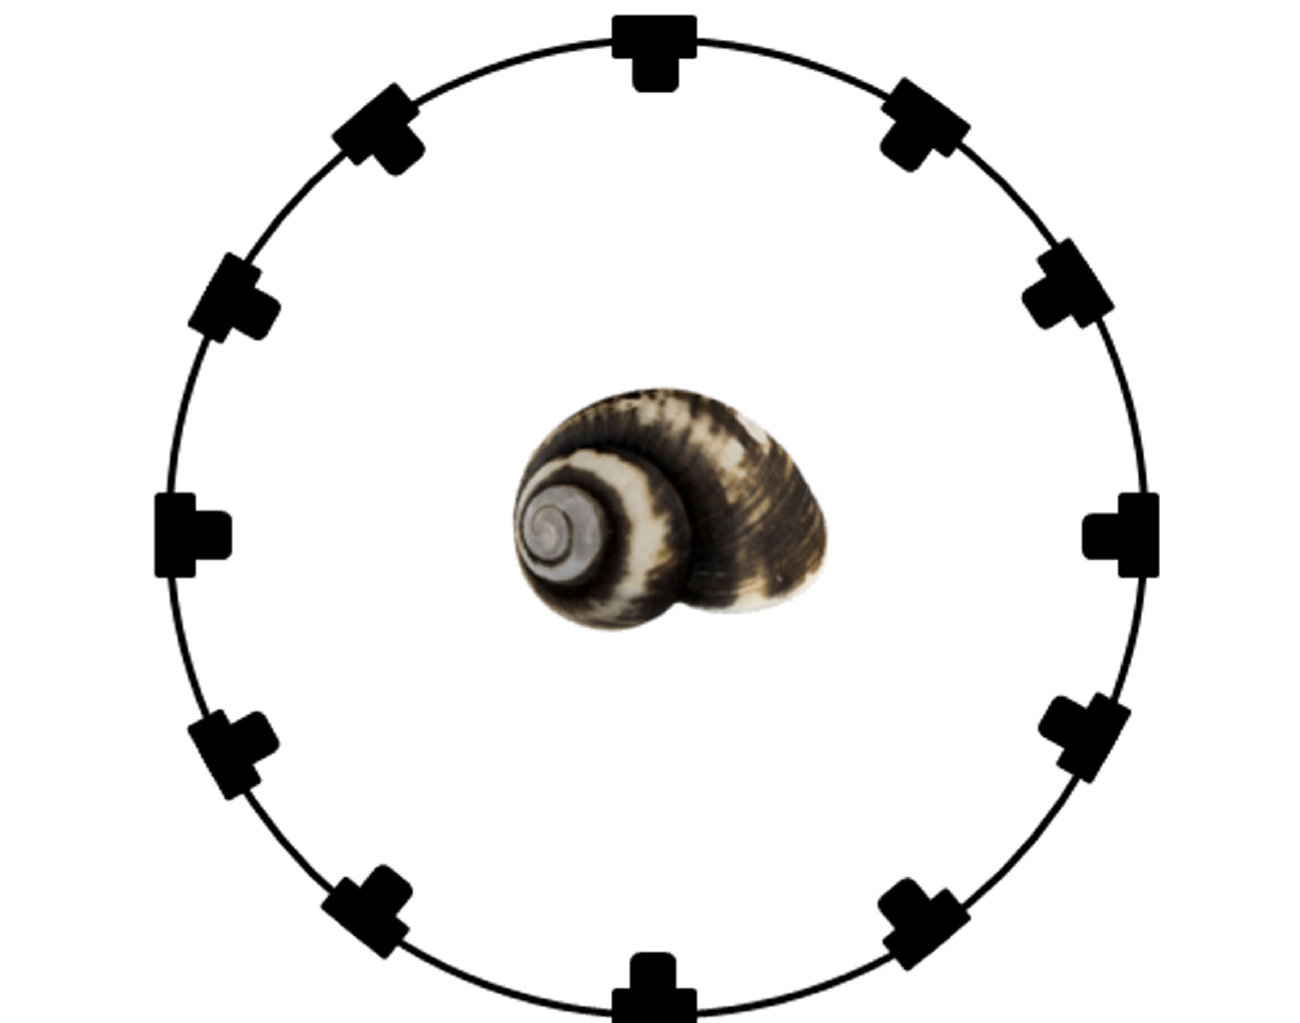
Fig. 3.2. Camera positions of a single rotation when taking pictures of an